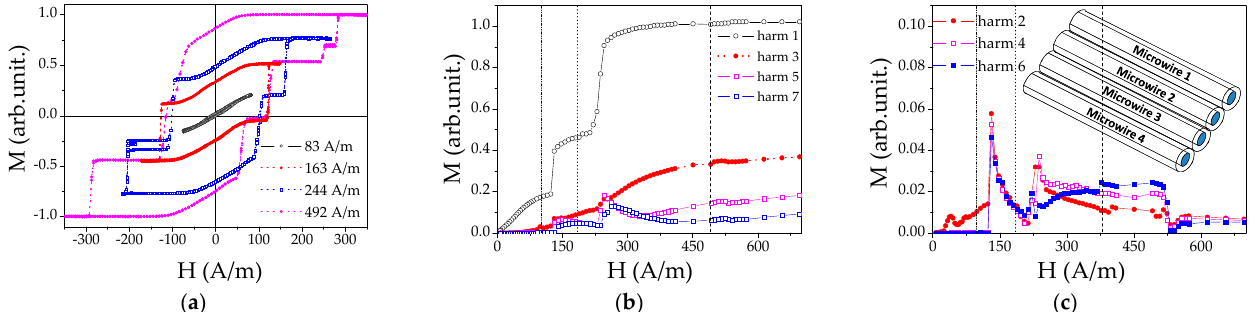
Figure 8. Hysteresis loops of four-wires system consisting of three Fe 74 B 13 Si 11 C 2 microwires and a Co 67 Fe 3.9 Ni 1.5 B 11.5 Si 14.5 Mo 1.6 microwire ( a ); odd and even harmonics vs. H 0 are given in ( b , c ), respectively. The schematic picture of the microwires array is provided in the inset of ( c ). Reprinted with permission from [51].